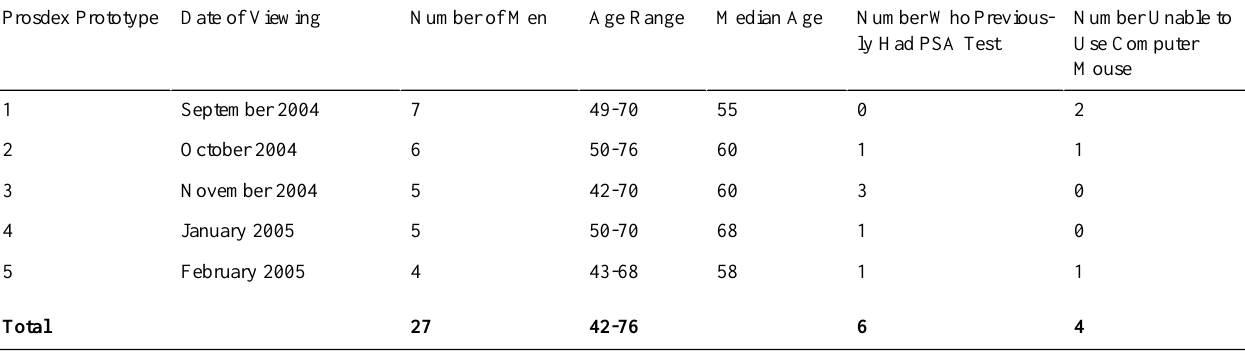
Table 2. Characteristics of the interviewed men